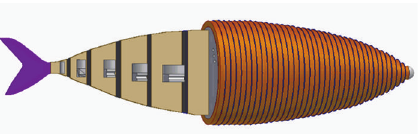
Figure 4: The CAD model of the fish robot. The front part (approximately half) is a rigid haul and the rest part (the tail) is flexible joint of rubber and wooden